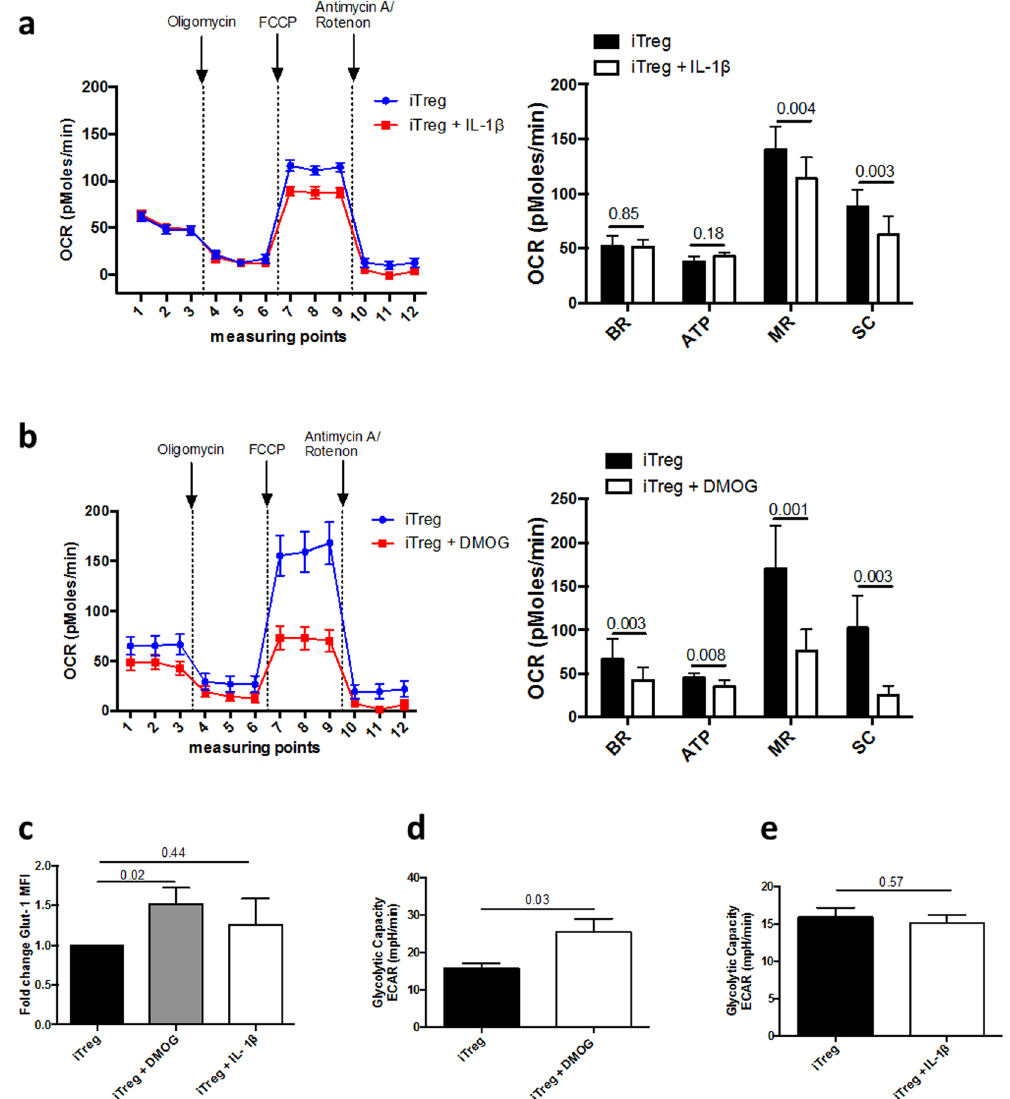
Figure 5. Impact of HIF-1 α induction on iTreg mitochondrial respiration. ( a , b ) Oxygen consumption rate (OCR) was measured in iTreg differentiated for 2 days in presence of IL-1 β ( a ) and 1 day in presence of DMOG ( b ) using a Seahorse instrument and the XF mito stress test kit. Basal respiration (BR) is the OCR measured before adding any additional compound. ATP production (ATP) is estimated based on the difference between basal OCR and OCR after oligomycin treatment. Maximal respiration (MR) is defined as the OCR after FCCP treatment. Spare capacity (SC) is the difference between maximal and basal respiration. Data of 3 independent experiments. ( c ) Mean ( ± SEM) Glut-1 expression measured by flow cytometry in iTreg, untreated or treated with IL-1 β or DMOG (n = 12). ( d , e ) Extracellular acidification rate (ECAR) was measured by seahorse in iTreg untreated or and treated with ( d ) DMOG or ( e ) IL-1 β . Mean ( ± SEM) values of 3 independent experiments are shown. P values correspond to paired